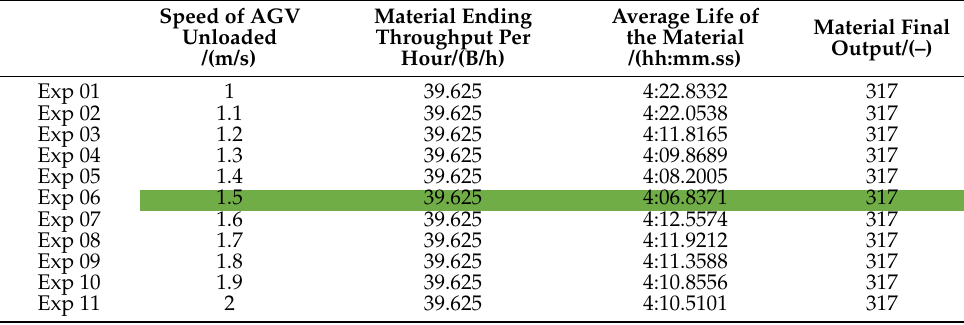
Table 11. Multi-level experiments for unloaded